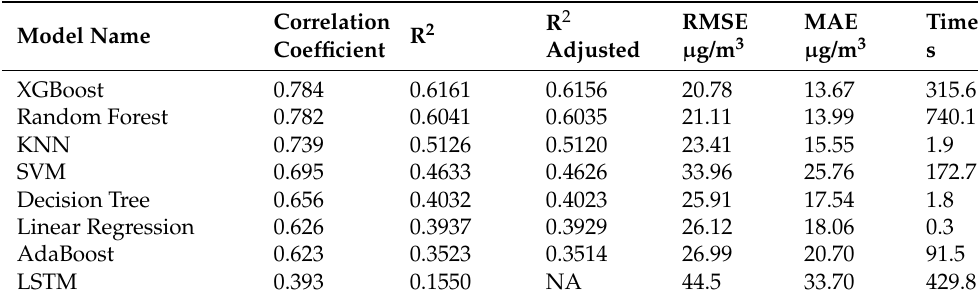
Table 3. Average performance of the 24 h ozone prediction from each machine learning model, tested for every hour for the full year of